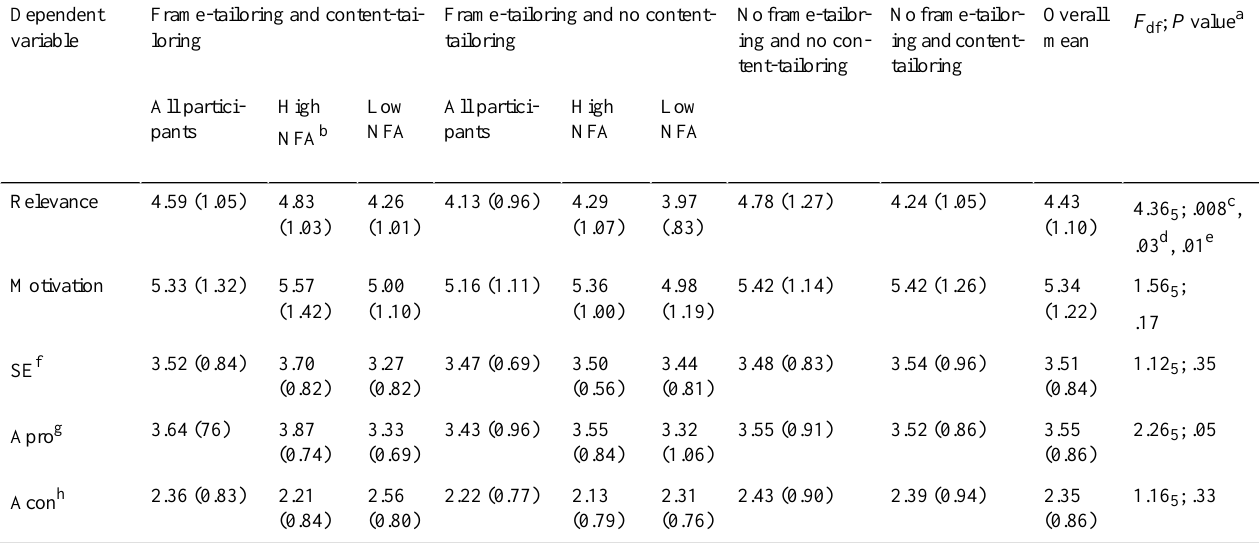
Table 3. Mean (SD) values per condition for all endogenous variables (N=273).